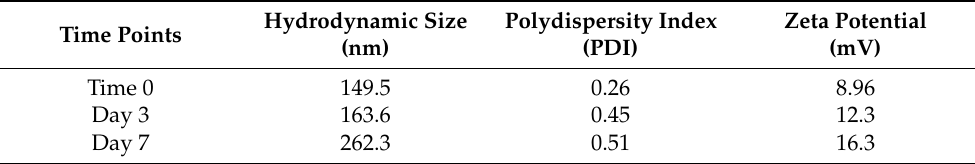
Table 5. HA − PTX + RTV − NMF-accelerated serum stability study at 37 ◦